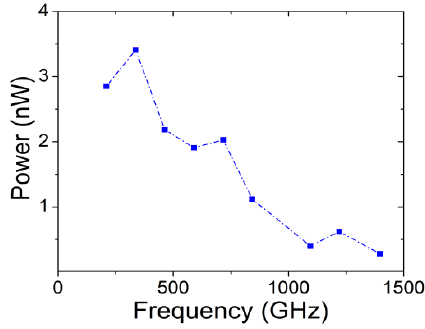
Figure 6. Power spectrum of 1550 nm photomixing.